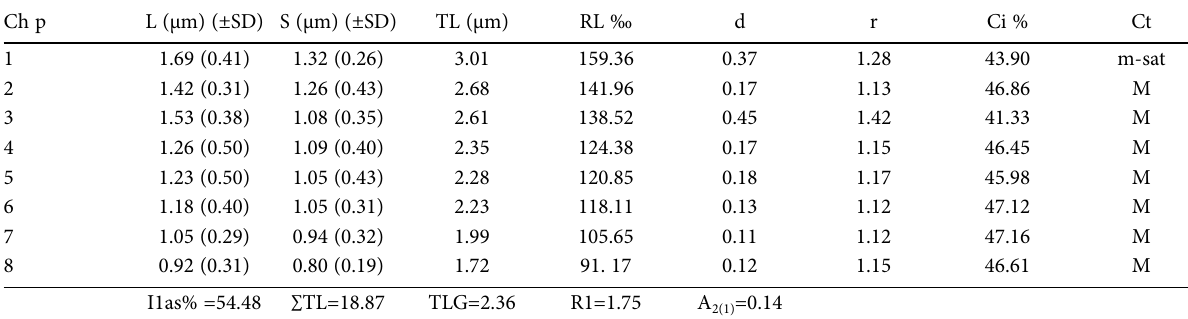
Table 2. Morphometric data within the population 22/10 (2n=16) of Trifolium subterraneum L. in Algeria. Ch